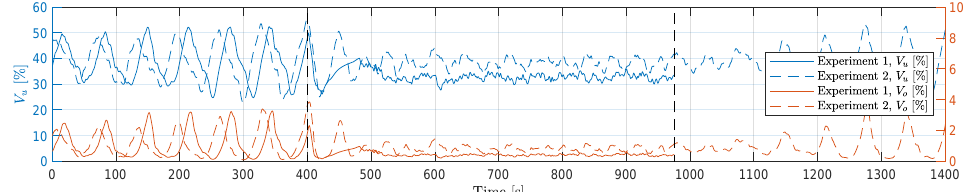
Figure 9. Hydrocyclone valve openings during both experiments.